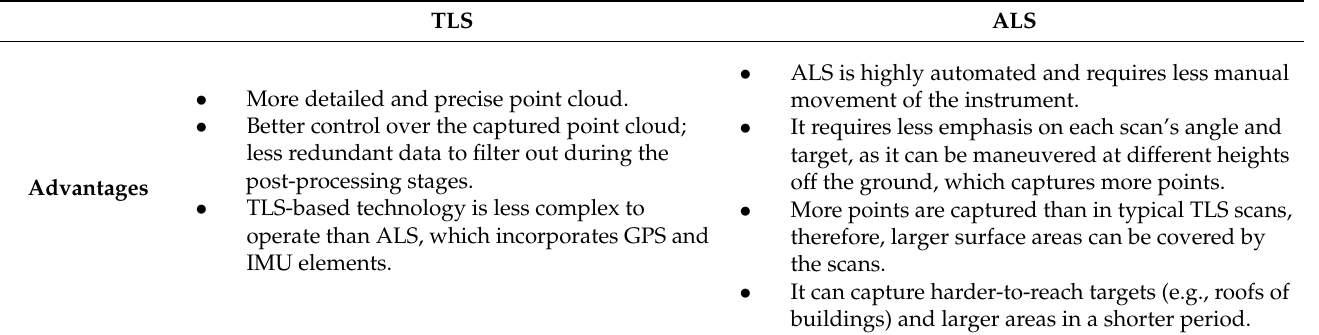
Table 1. Comparison of advantages and disadvantages of TLS and ALS.